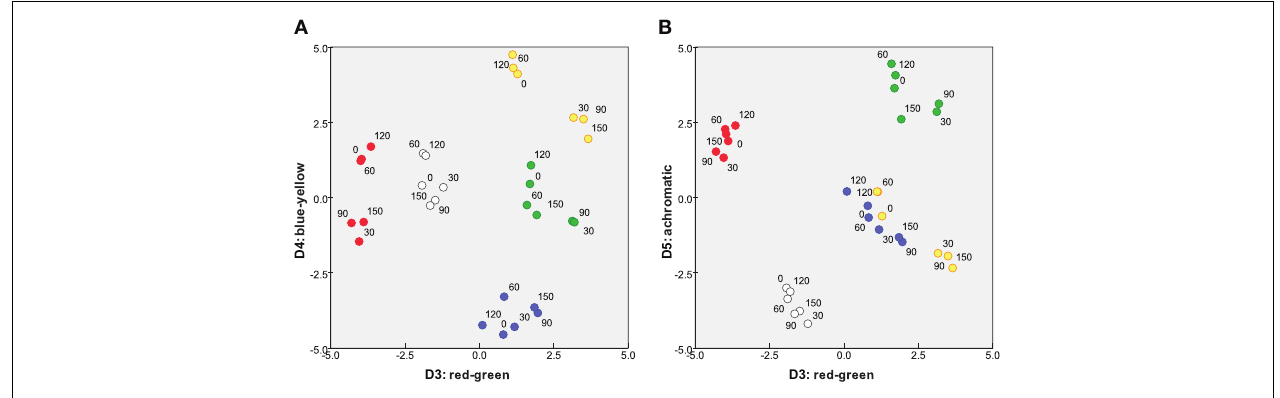
FIGURE 4 | Two projections of color subspace of 5D MDS solution. Coordinates of stimuli on (A) D 3 and D 4, red-green and blue-yellow; and (B) D 3 and D 5 “achromatic” dimension. Table 3 | Parameters of individual and mean data from the MDS and Minkowski-metric analyses.